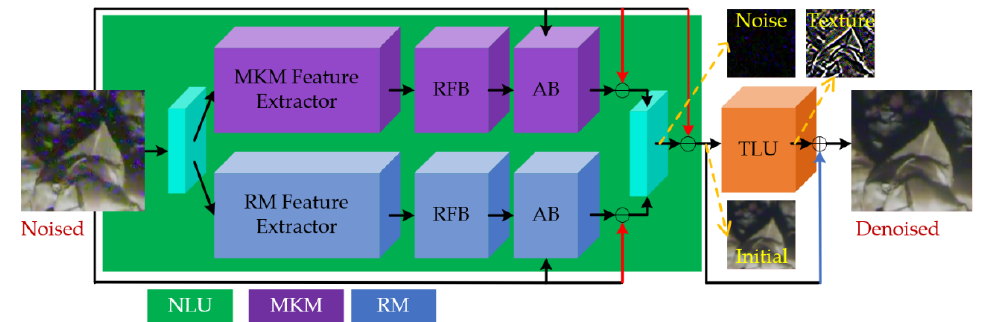
Figure 3. The overall network framework. The purple pipeline represents the multi-scale kernel module (MKM), the dark blue pipeline represents the residual module (RM); the green area is the first sub-network noise learning unit (NLU), and the orange area is the second sub-network texture learning unit (TLU). The light blue parts represent the input or output convolution layers, playing the role of feature fusing. The red arrows indicate element-wise subtractions, and the blue arrow indicates an element-wise addition.